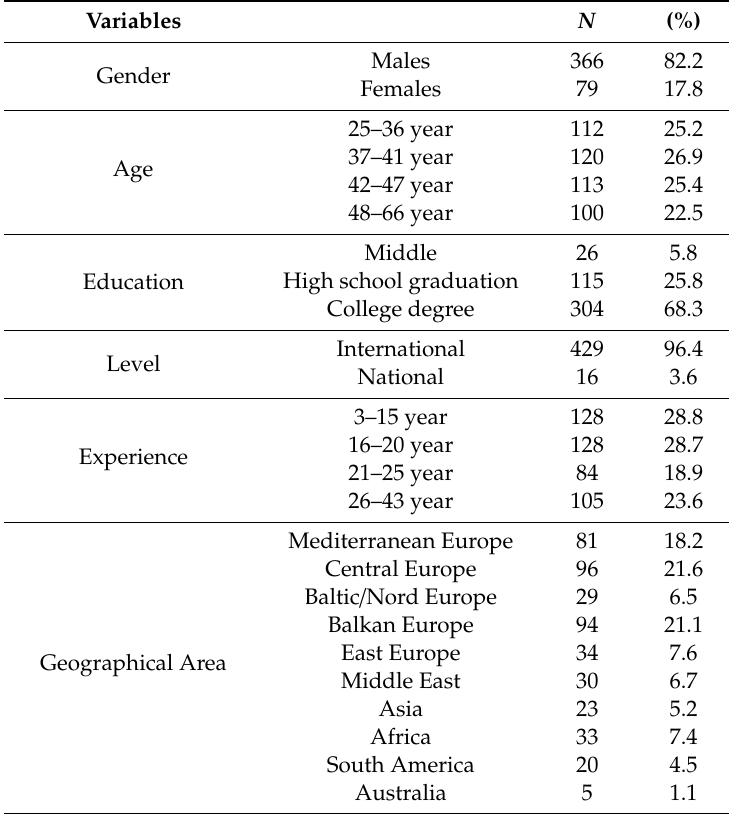
Table 1. Sociodemographic characteristics of the